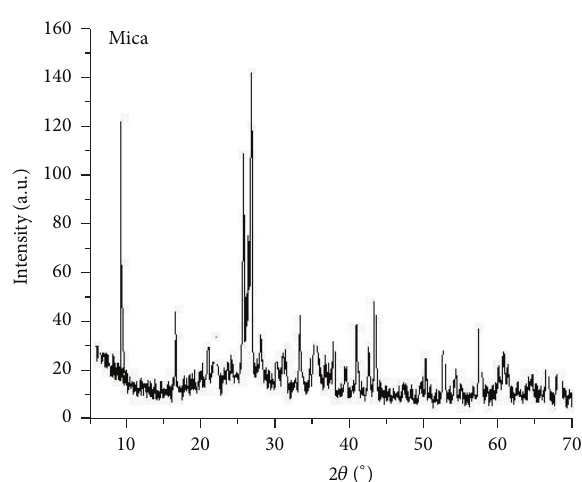
Figure 1: Diffractogram of the initial mica sample, series M 0 .